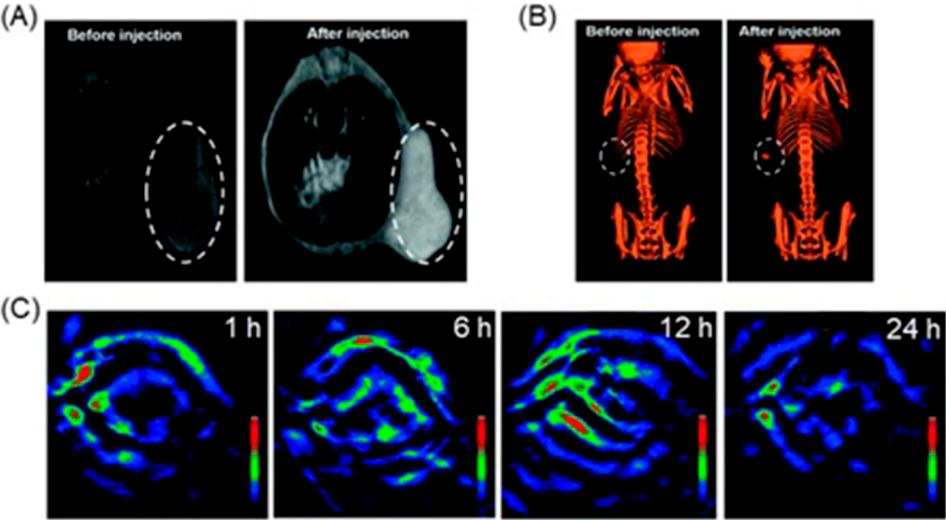
Figure 19. ( A ) T 1 -weighted MRI and ( B ) X-ray CT images of pre and 12 h post-injection of nano- sponges into a 4T1 tumor-bearing mouse. ( C ) Multispectral optoacoustic images of 4T1 tumor in- jected with nanosponges. Dashed circles in ( A , B ) represent the tumor region. Adapted from Bio- materials , 220 , Wang, Y.; Song, S.; Lu, T.; Cheng, Y.; Song, Y.; Wang, S.; Tan, F.; Li, J.; Li, N. Oxygen- supplementing mesoporous polydopamine nanosponges with WS 2 QDs-embedded for CT/MSOT/MR imaging and thermoradiotherapy of hypoxic cancer. 119405, Copyright 2019, with permission from Elsevier [290].